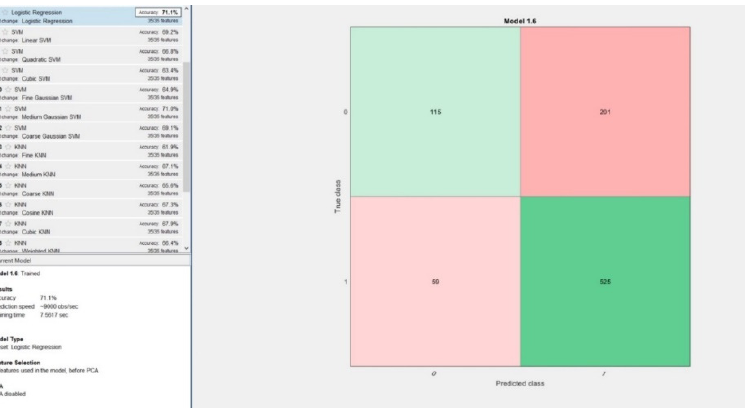
Figure 5. Best performing model obtained using 5-fold cross validation: Logistic Regression.